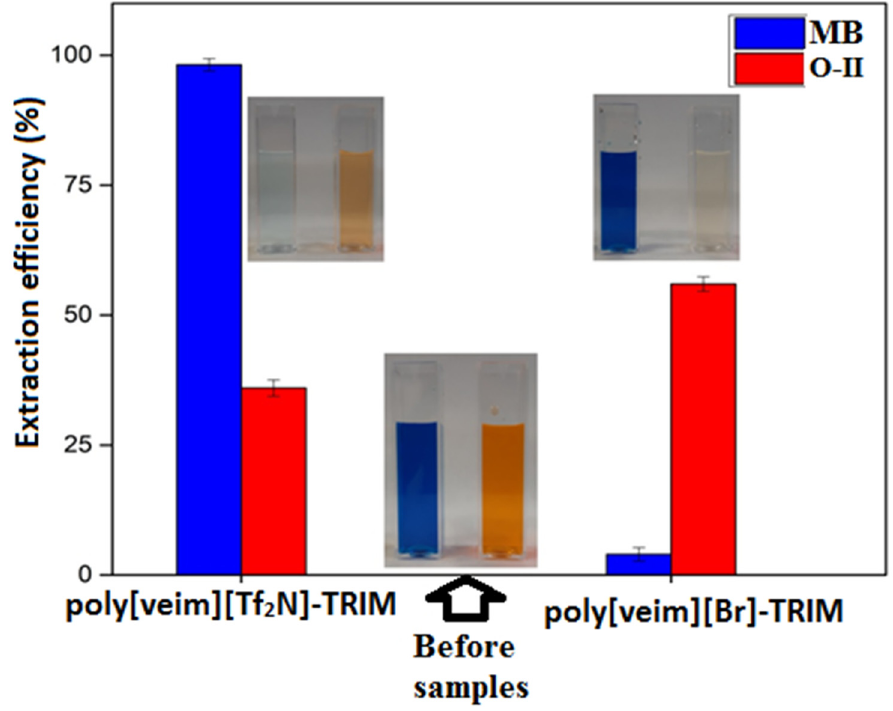
Figure 6. Dye extraction efficiency with different adsorbents (C 0 = 50 mg/L, m = 0.5 g/L).